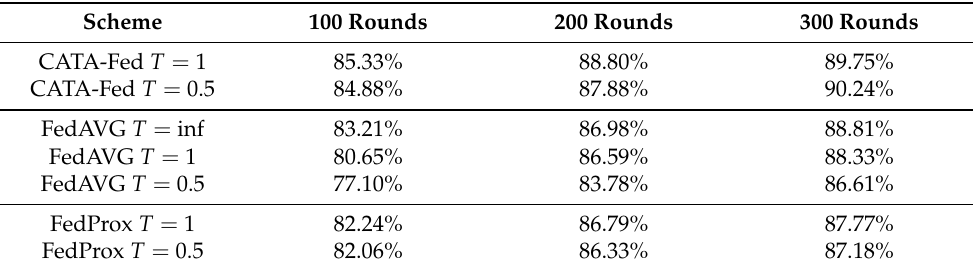
Table 2. Peak test accuracy in Fashion-MNIST with global iterations